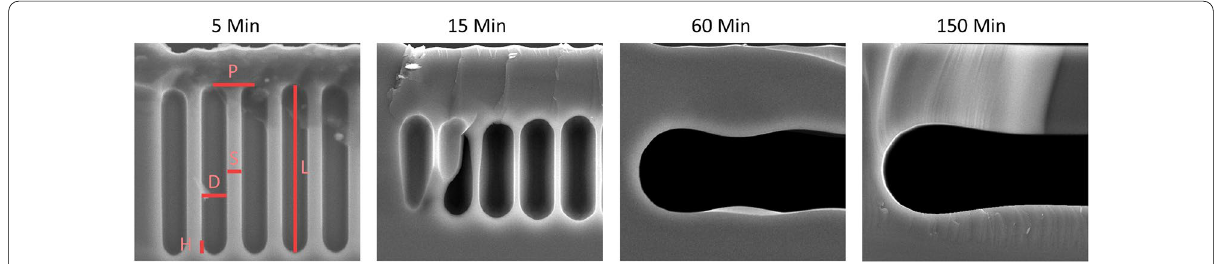
Fig. 2 Cross-sectional SEM images of GON used as training data. Cross-sections are analyzed via destructive test at four different annealing times: 5, 15, 60, and 150 min Red lines on the 5 min image denote the essential parameters extracted from the sub-surface